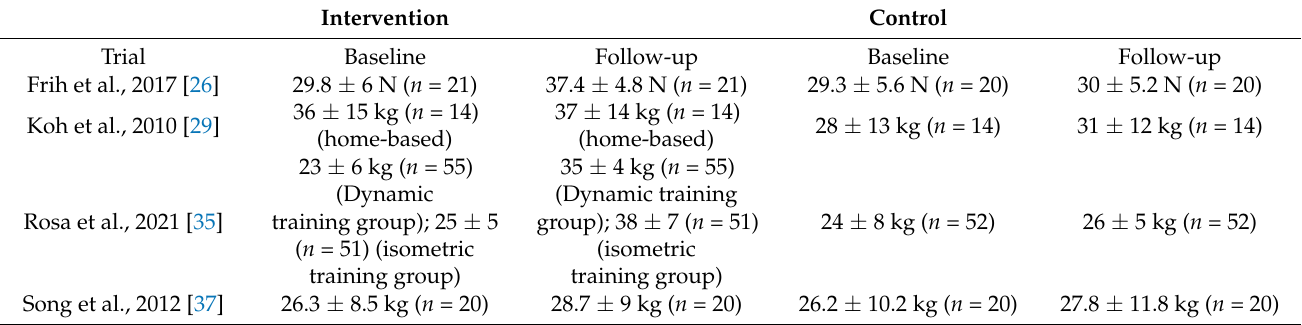
Figure 4. Effect of intradialytic exercise on sit-to-stand test 60 (repetitions) in individuals receiving haemodialysis. Data are expressed as mean difference and 95% CI. * Data for exercise and control groups only [16,17,21,27,30,38,42]. Table 4. The effect of exercise programmes outside of haemodialysis treatment on grip